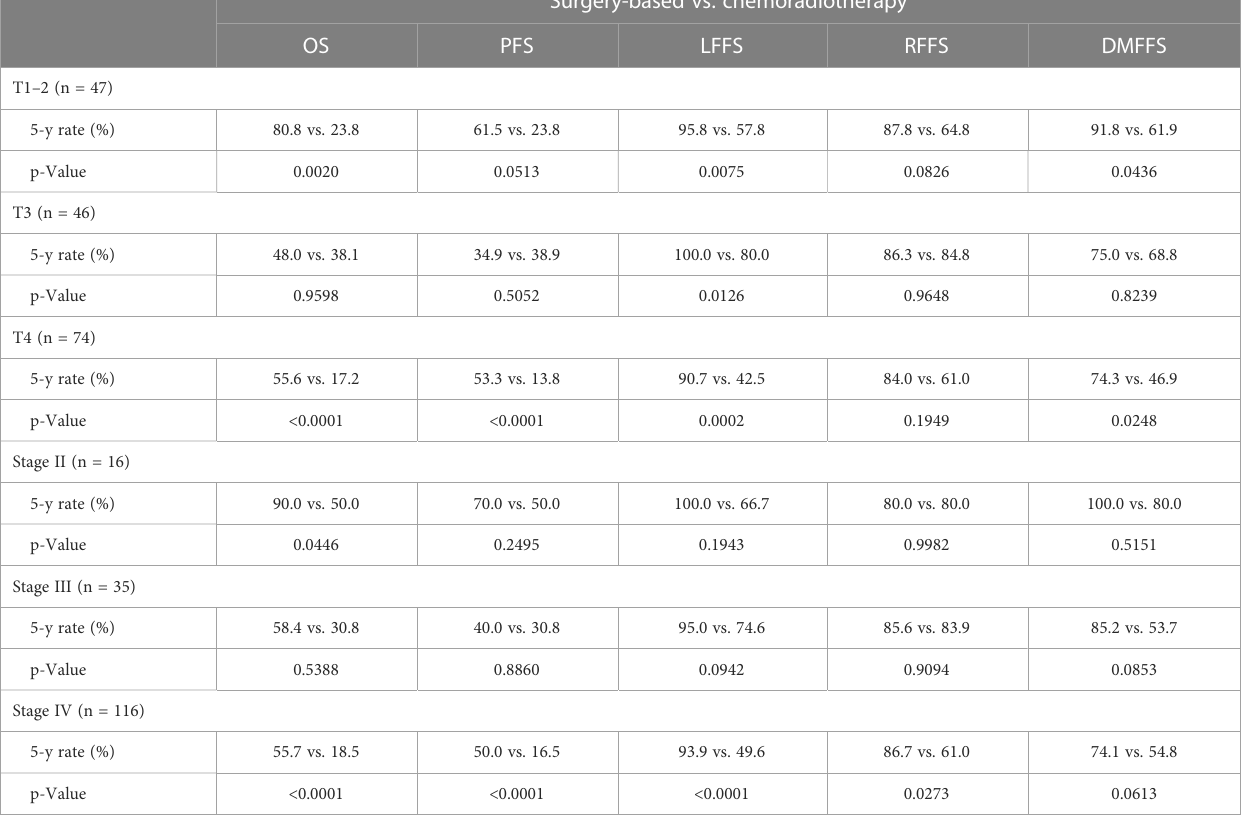
TABLE 3 Survival comparison between surgery-based treatment versus chemoradiotherapy by T-classi fi cation and overall stage. Surgery-based vs.